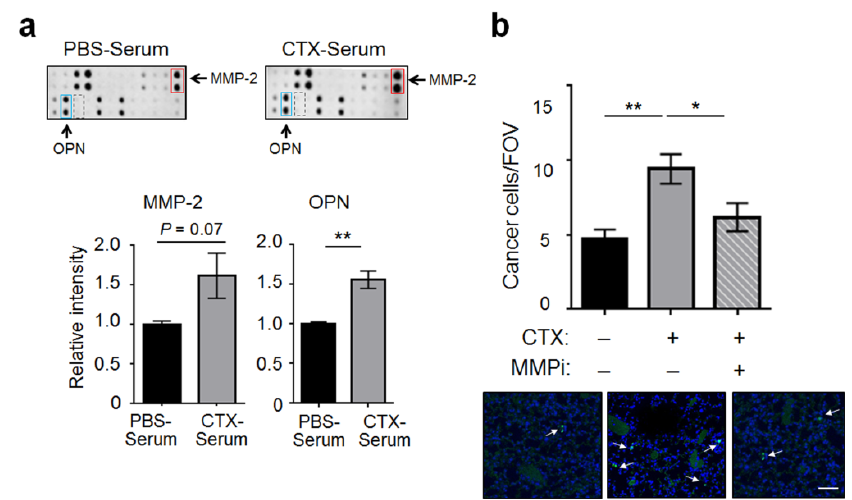
Figure 4. CTX increased the serum level of MMP-2, which was functionally important for CTX to increase the adhesiveness of vascular walls. ( a ) Top : A portion of the protein array is shown for MMP-2 (red box), OPN (blue box), and MMP-9 (dashed box). Bottom : Signals of MMP-2 and OPN were normalized as detailed in Materials and Methods (subtract the background and normalized against the positive controls). The normalized signals from the PBS-serum blot were arbitrarily defined as 1. ( b ) Mice were pre-treated with CTX (+) or vehicle ( − ), followed by injection of MMP- 2/9 inhibitor III (MMPi) (+) or vehicle ( − ) 24 and 72 h after CTX treatment. Cancer cell number per FOV at 3 h post-injection were analyzed ( n = 6–9 from 2 independent experiments). Bottom : Representative images. Arrows indicate cancer cells, which are discrete and bright, in contrast to the background noise of faint and diffuse nature (presumably due to the auto-fluorescence of bronchioles and/or blood vessels). Scale bar, 50 µ m. Bars indicate mean ± SEM; one-way ANOVA with post hoc Holm–Š í d á k correction; * p < 0.05; ** p <